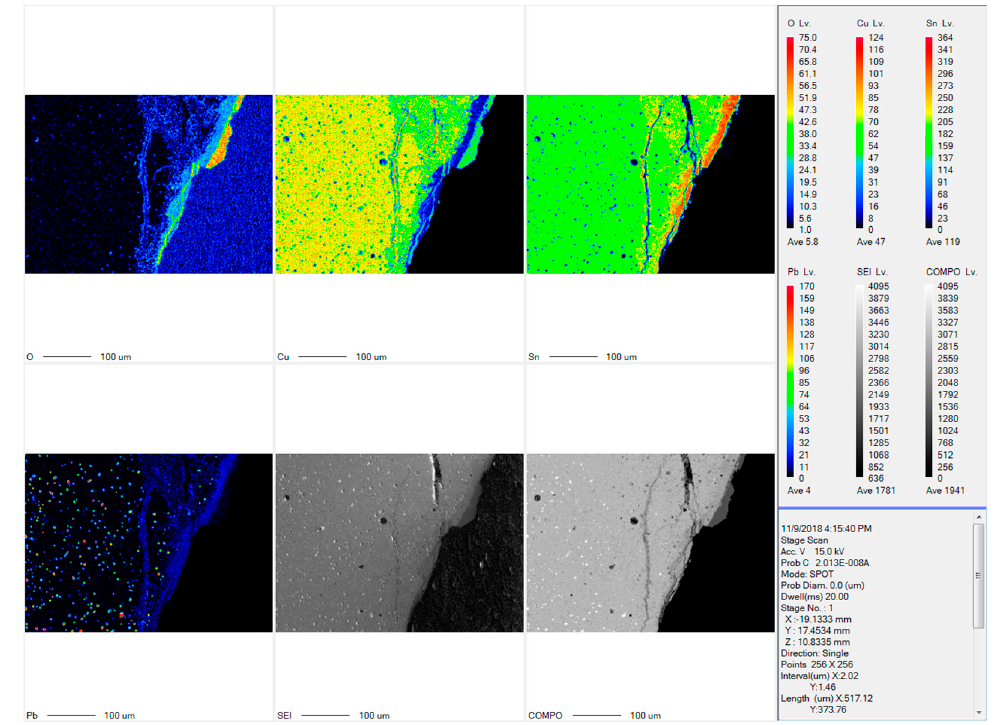
Figure 6. Ga-31 (No. 2) electron probe microanalyzer (EPMA) mapping image. The microstructure consisted of α + δ eutectoid and δ phases with sporadic sulfide and lead particles (Figure 7a). Its secondary copper likely formed as clumps in the corroded